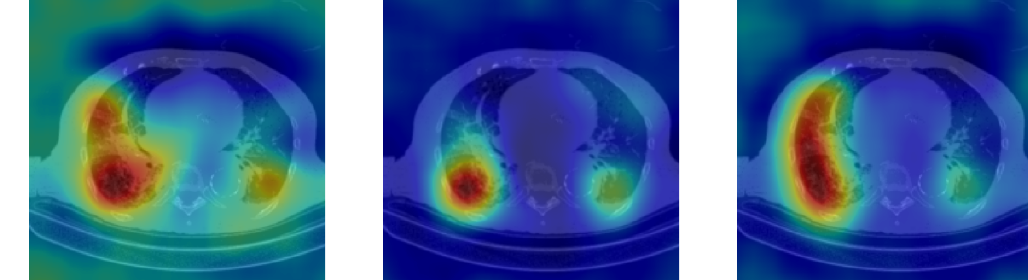
Figure 14. RISE heat map examples of Cap slice image using the trained multi-tasks CNN architectures (ResneXt-50, Densenet-161, Inception-v3, and Wide-Resnet-50). The first example is shown in the first two rows, where the images represent the input slice image and segmented lung lobes results, followed by the heat maps of ResneXt-50, Densenet-161, Inception-v3, and Wide-Resnet-50, respectively. The second example is in rows 3 and 4.